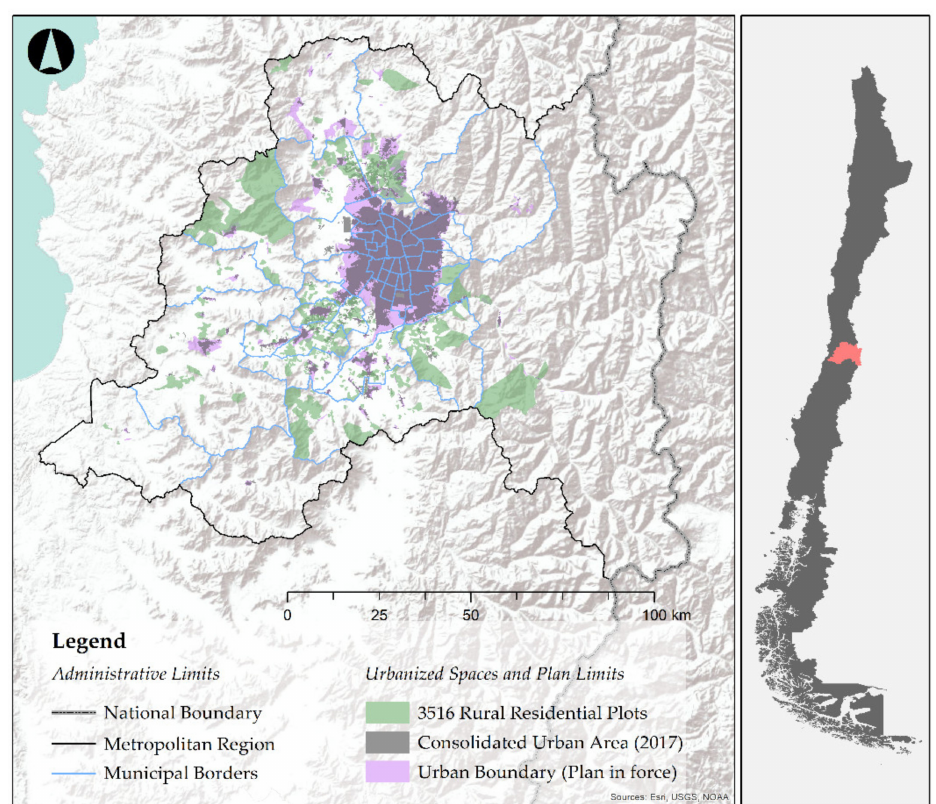
Figure 1. Location of rural residential plots (RRPs) in the Metropolitan Region of Santiago de Chile (MR). Source: Own elaboration, based on INE